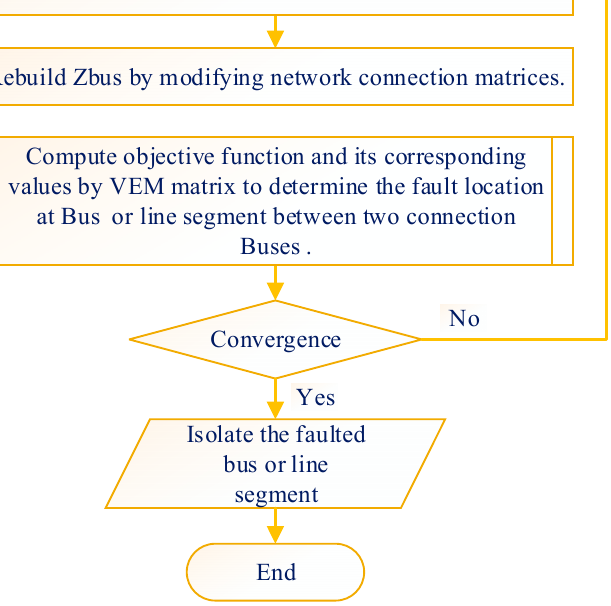
Figure 3. Proposed fault location approach of the MG.